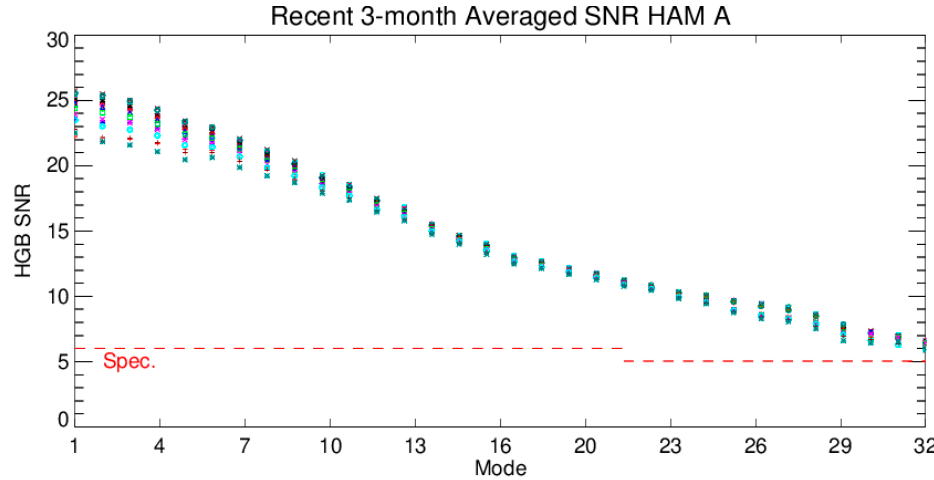
Figure 9. Recent 3-month averaged SNR versus Modes in HGS-B for HAM-1. Different colors are used to plot the DNB 16 detectors.